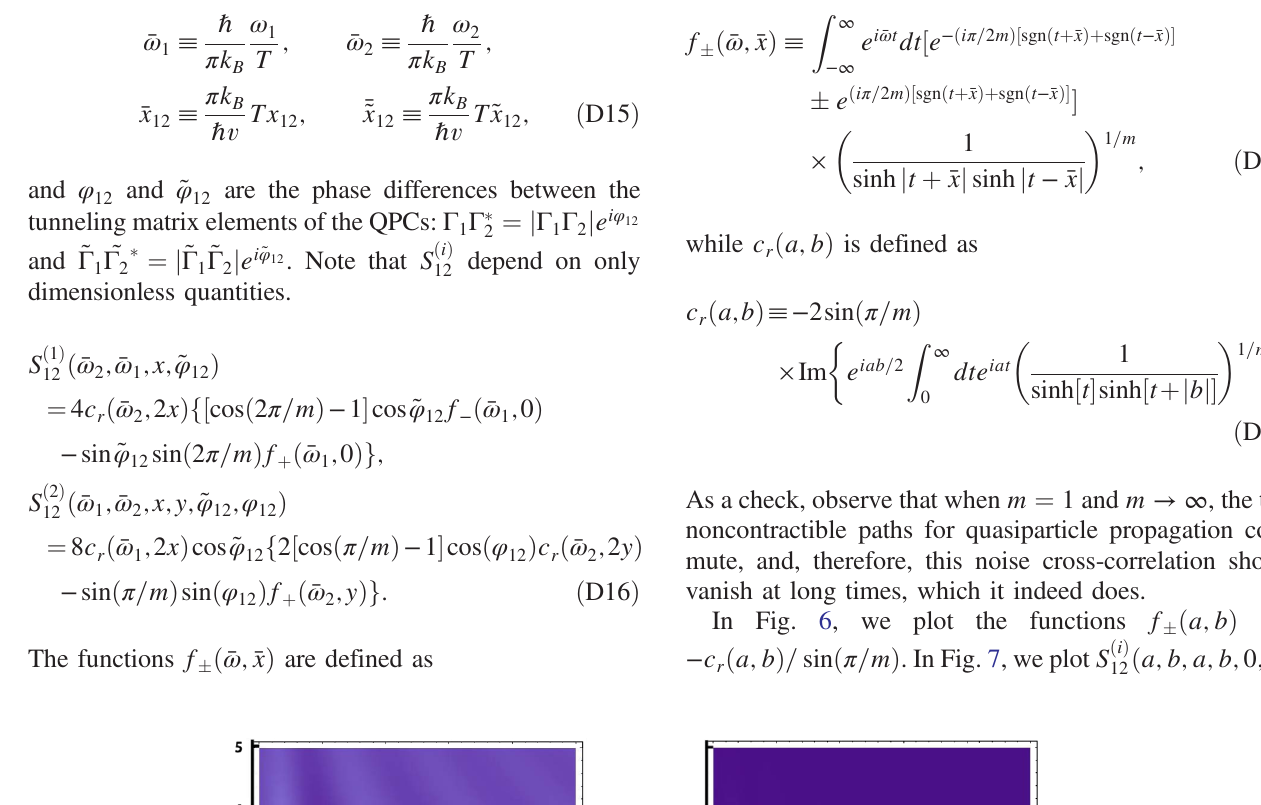
a; b Þ = 2 sin ð π =m Þ , (b) f − ð a; b Þ , and (c) f r ð